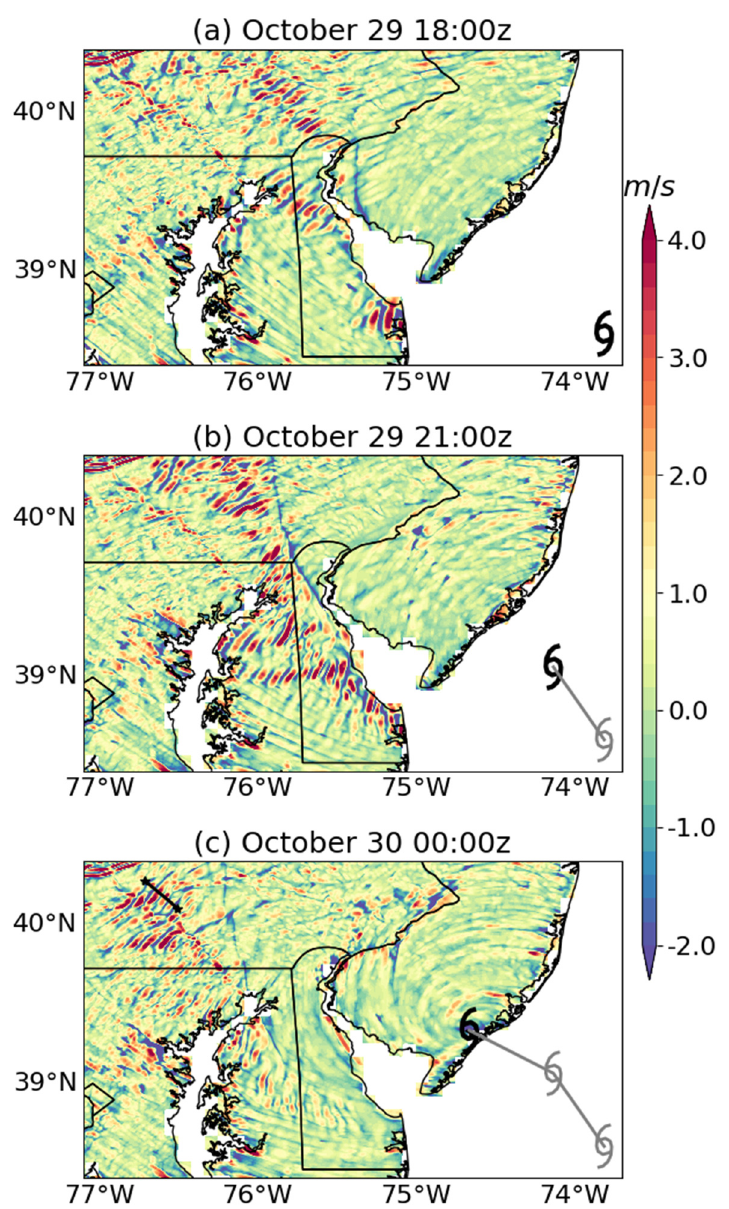
Figure 6. The WRF wind speed perturbations at about 30 m height before Sandy’s landfall time. Red (blue) indicates enhanced (diminished) wind speed. Tropical cyclone symbols indicate the storm center, with the bold symbol denoting storm center location at the time of each frame. Only wind speed perturbations over land are shown to highlight the presence of roll perturbations over land. Figure ( a – c ) shows WRF wind speed perturbations at 1800 UTC 29 October 2012, 2100 UTC 29 October 2012, and 0000 UTC 30 October 2012,